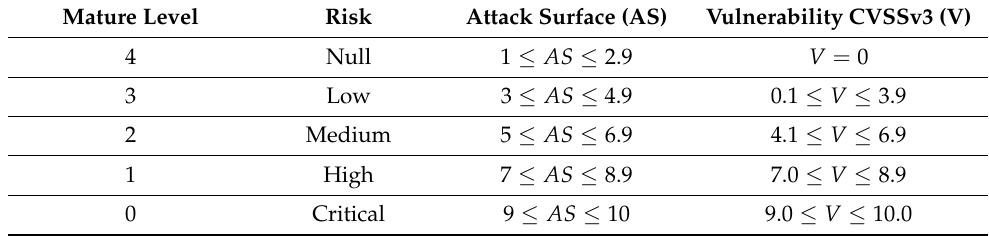
Table 11. IoT system mature